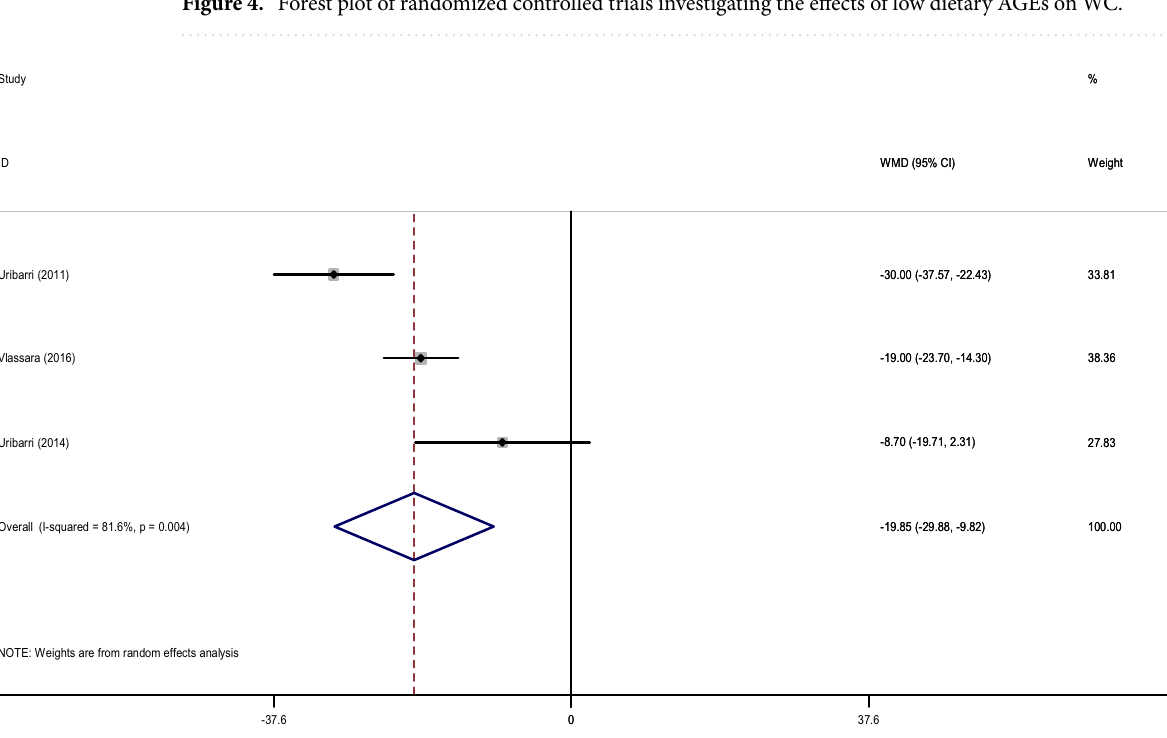
Figure 4. Forest plot of randomized controlled trials investigating the effects of low dietary AGEs on WC.